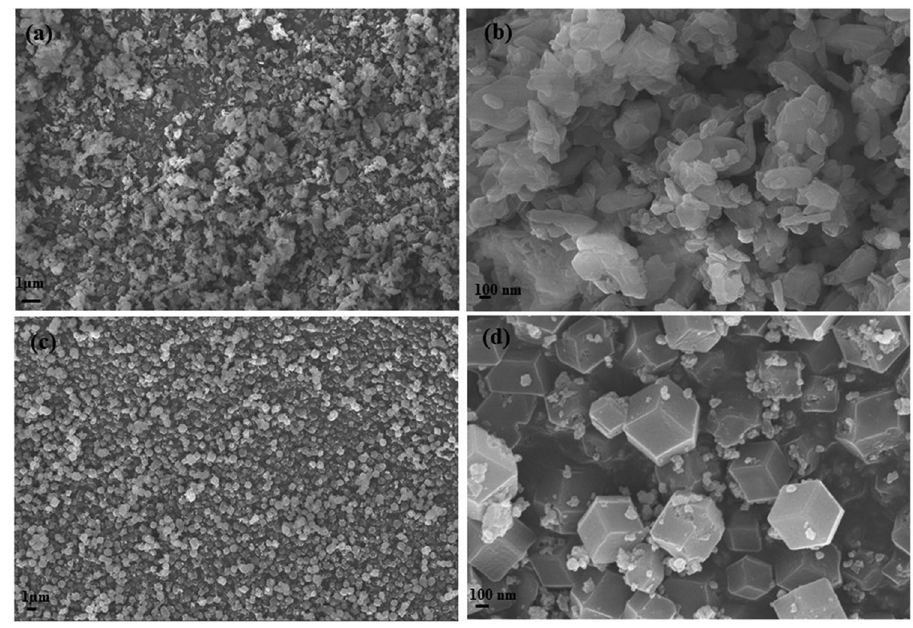
Figure 5: FE - SEM images of ( a and b ) CdS@ZIF - 8 and ( c and d ) CTAB - capped CdS@ZIF - 8.